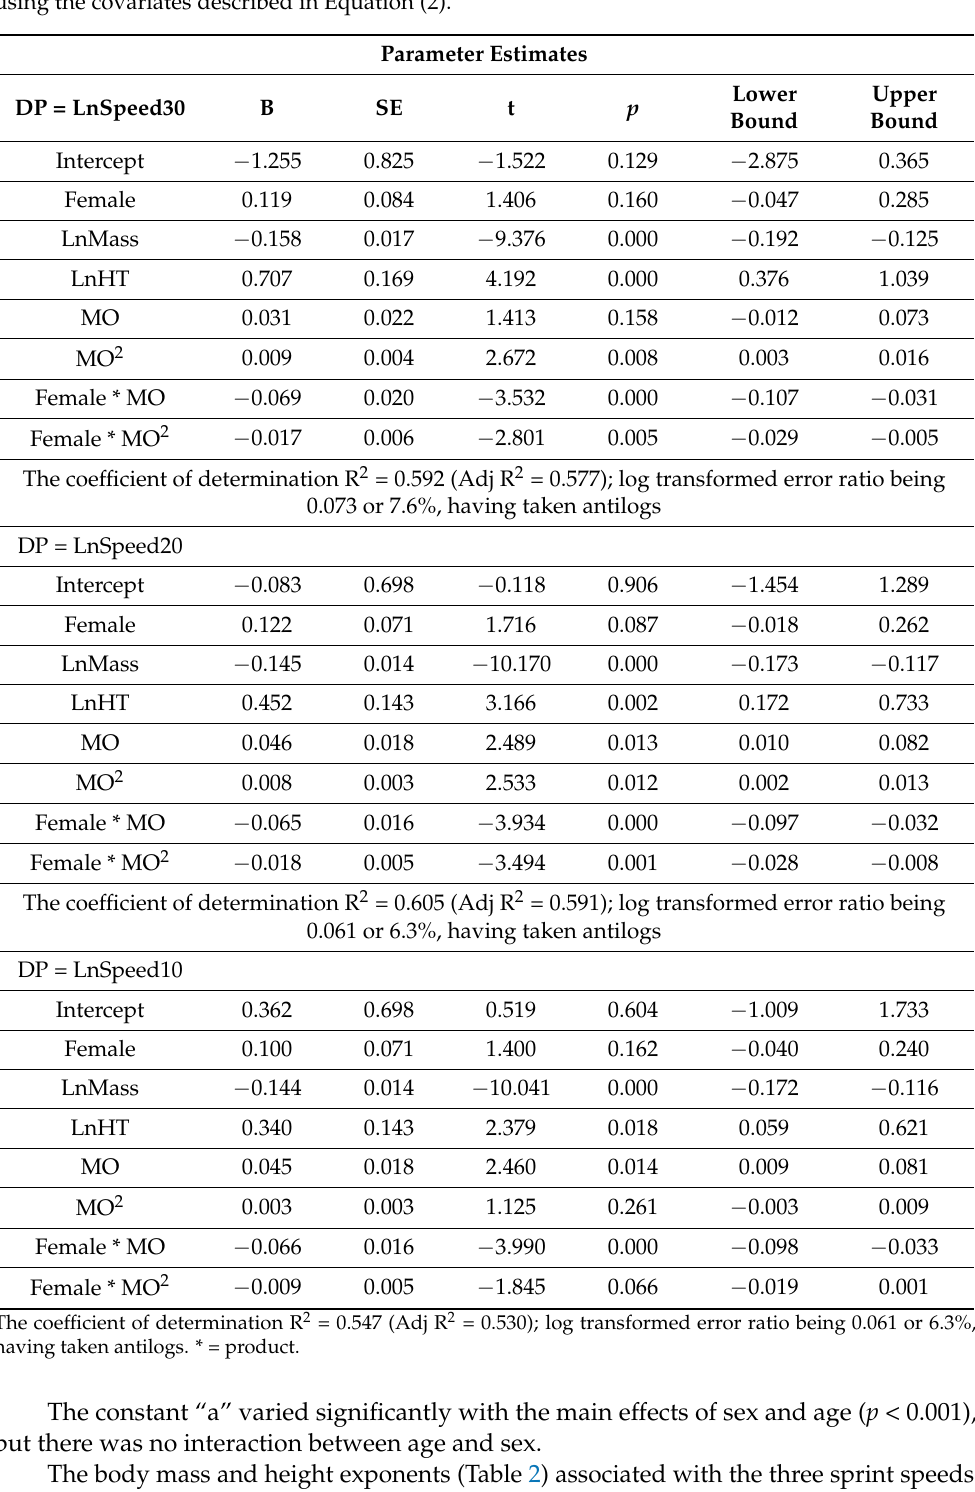
Table 2. The fitted ANCOVA parameters predicting log-transformed 30, 20 and 10 m speed (m.s − 1 ) using the covariates described in Equation